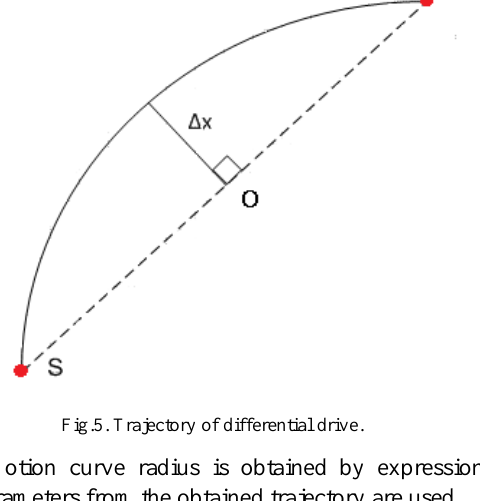
Fig.5. Trajectory of differential drive.